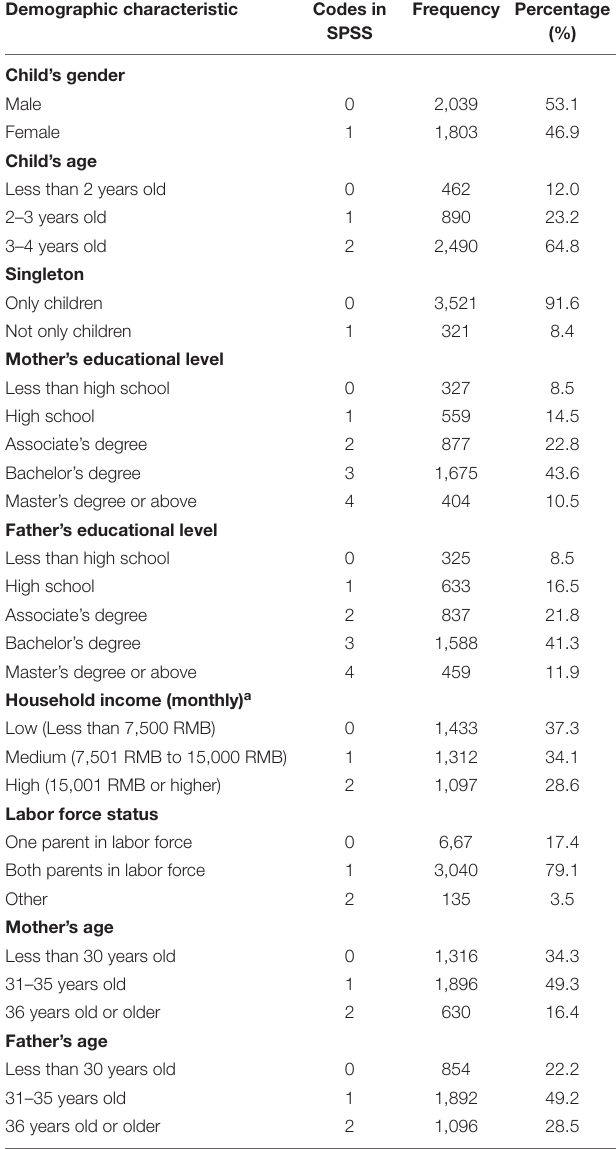
TABLE 1 | Participant characteristics ( N =